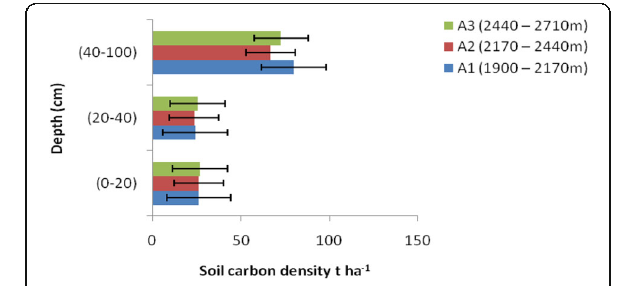
Fig. 7 Depthwise variation of soil carbon density t ha − 1 at three